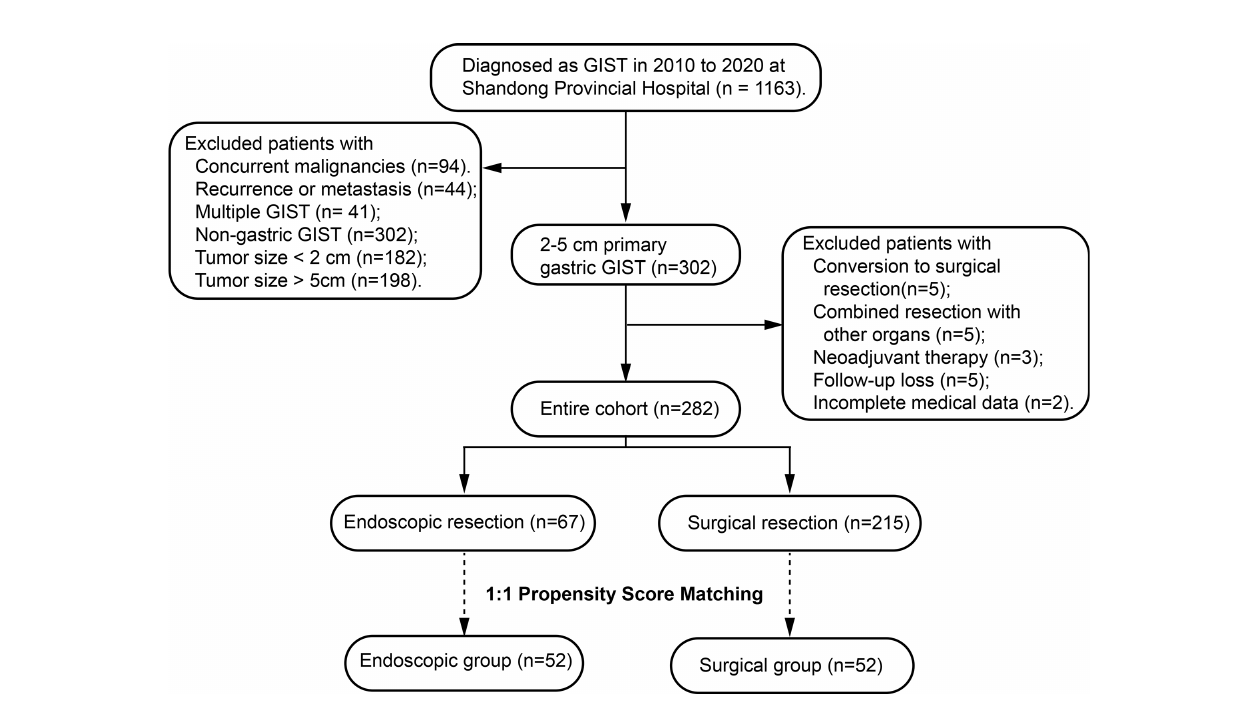
FIGURE 1 | Flow chart of this